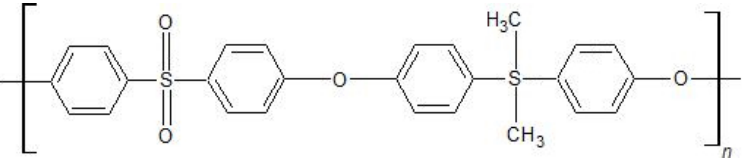
Figure 5. Schematic representation of the PSU polymer.